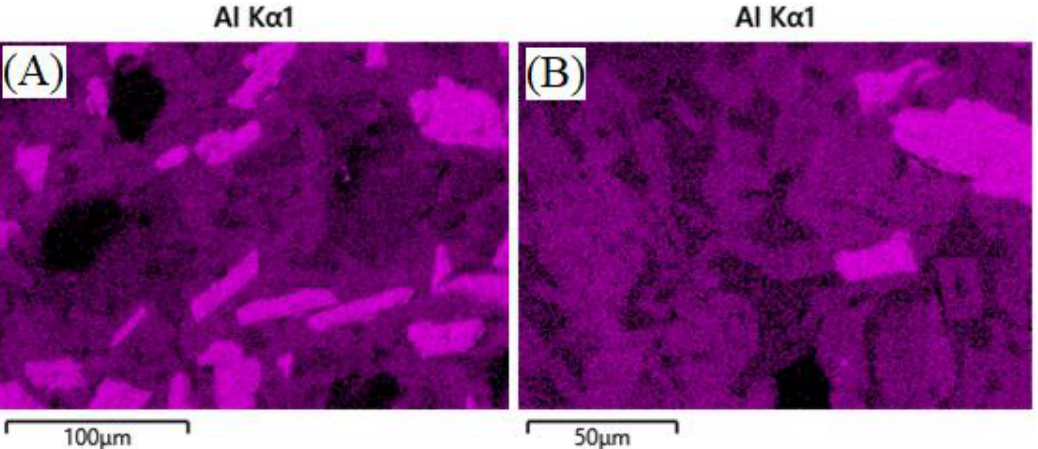
Figure 7. Surfaces of ASH-G composite after heating to 775 °C for 240 h without ( A ) and with ( B ) KCl. A reduced glaze is present in both cases.